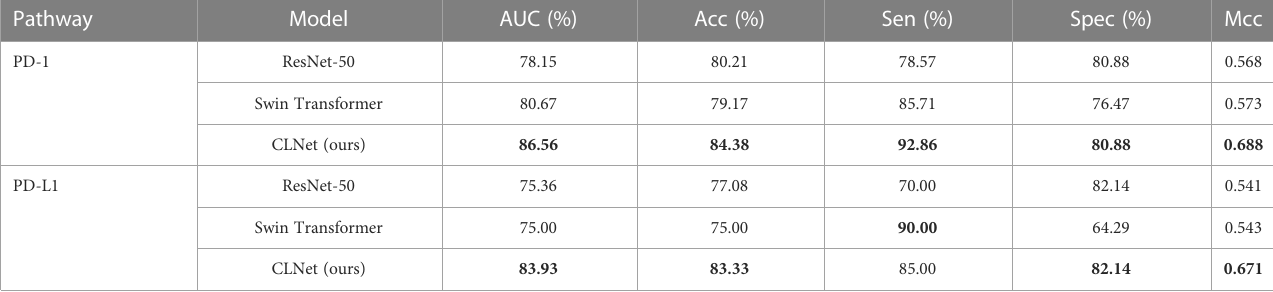
TABLE 7 Performance comparison among supervised ResNet-50, supervised Swin Transformer and our self-supervised CLNet. Pathway